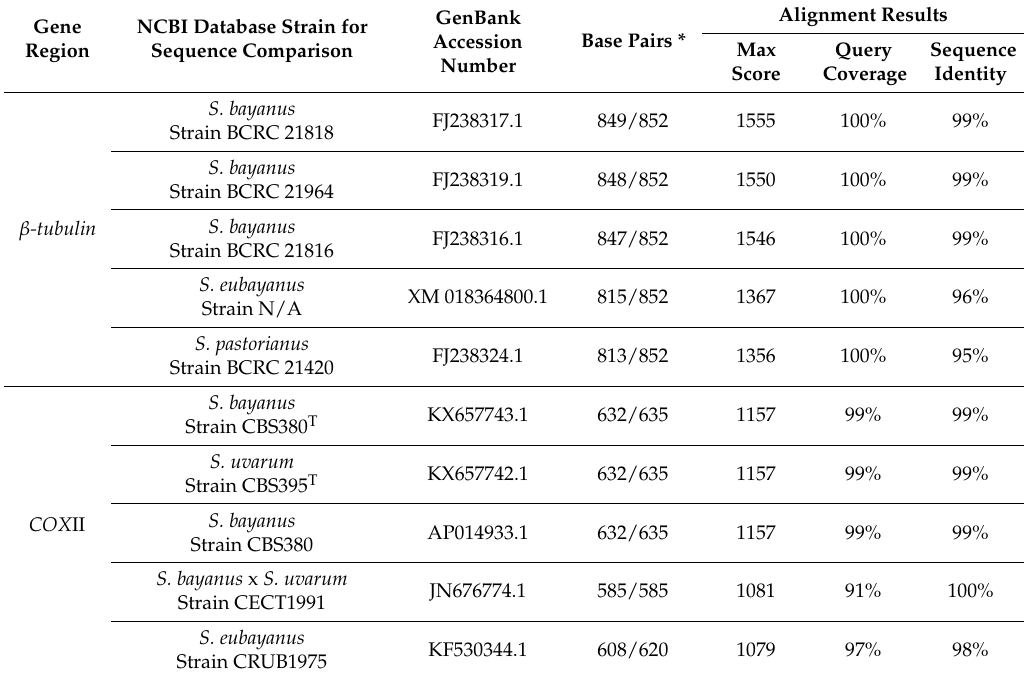
Table 1. Homology of CN1 mitochondrial genes with GenBank